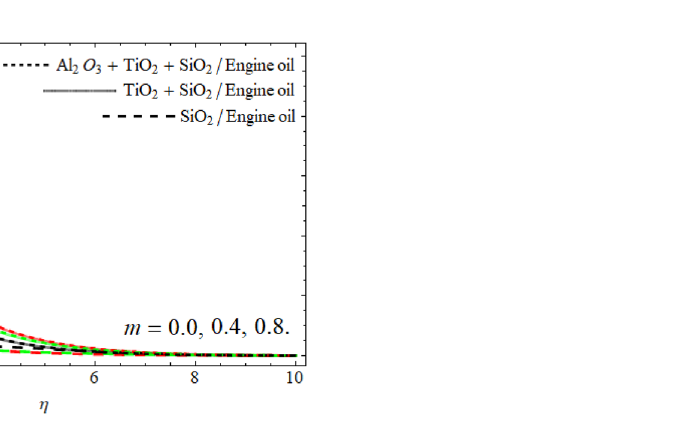
Figure 5. Velocity f ′ (η) field versus power law number m